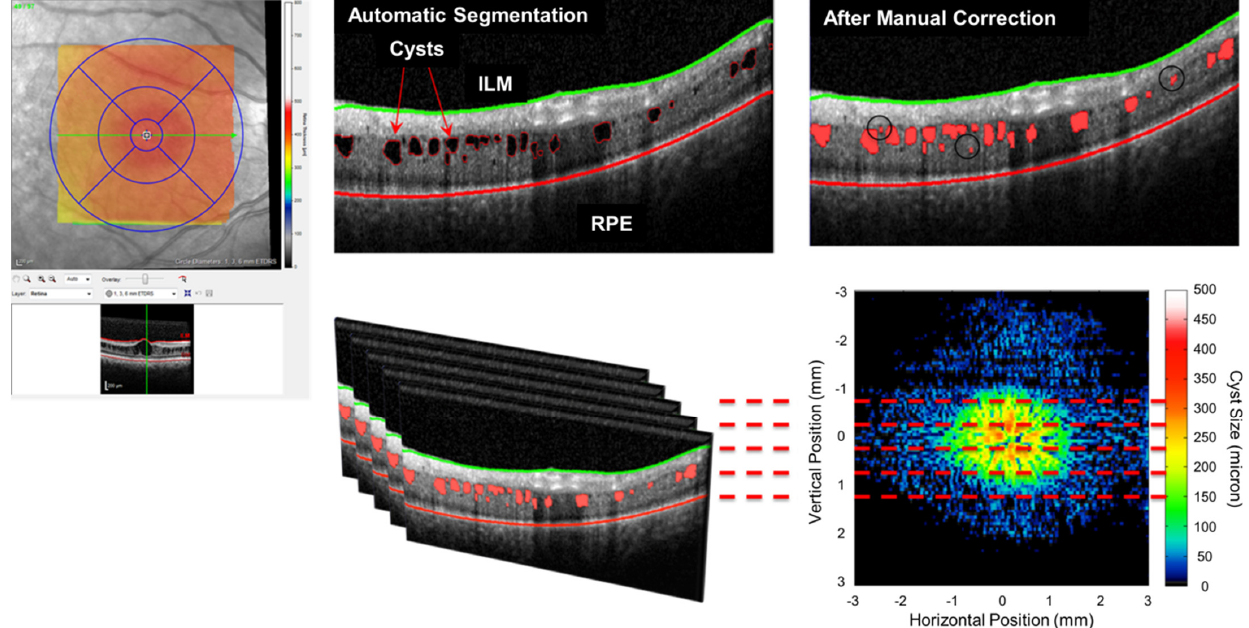
Figure 7. An application of using cyst segmentation in OCT for a patient with XLRS. The figure is reprinted with permission from Ref. [78]. Pennesi, 2018.